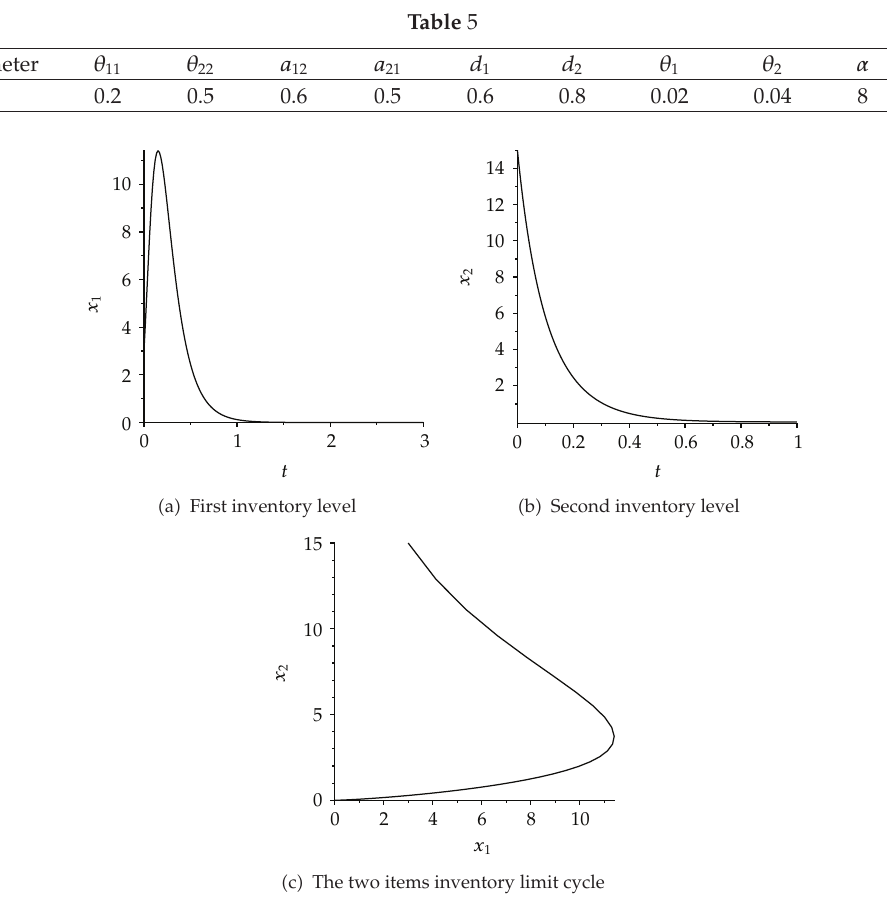
(cid:6) 2 (cid:7) when the supply rates are linear function of the inventory levels, u the linear stability conditions are reduced